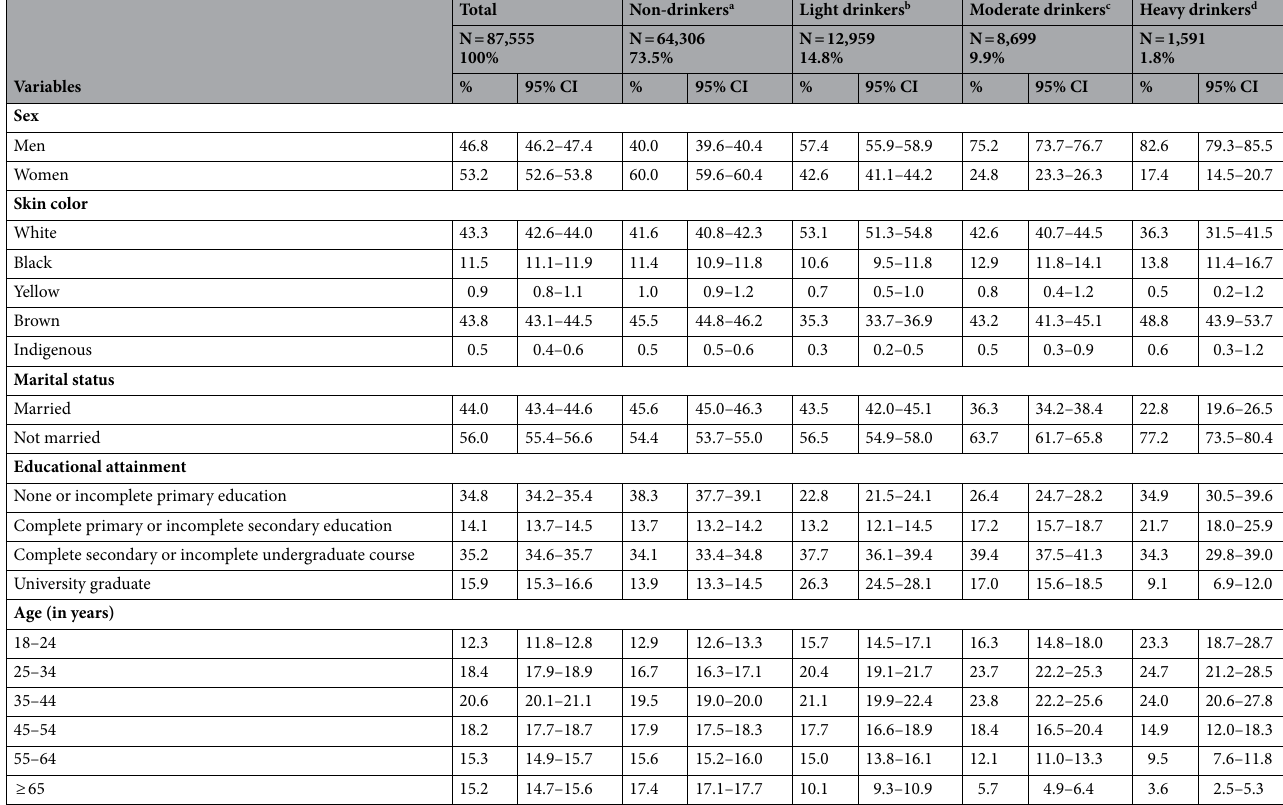
Table 1. Characteristics of the participants according to patterns of alcohol consumption (N = 87,555). Results include sample weights and control for survey design. a Defined as reporting having 0 g/day of pure alcohol in the past 30 days. b Defined as reporting having between 1 and 12.5 g per day of pure alcohol in the past 30 days. c Defined as reporting having between 12.6 and 49.9 g per day of pure alcohol in the past 30 days. d Defined as reporting having between ≥ 50 g per day of pure alcohol in the past 30